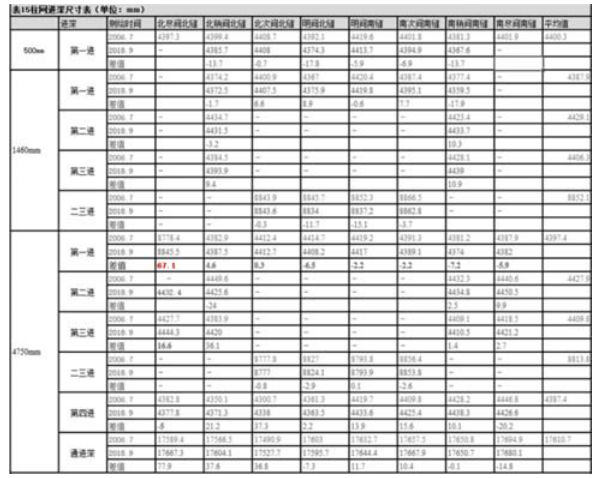
Table 1. Center distances from the top of the columns